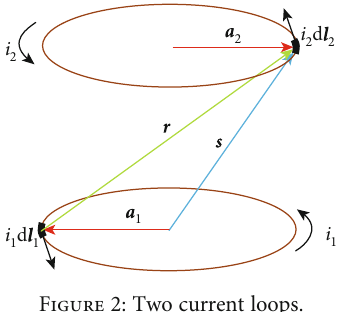
Figure 2: Two current